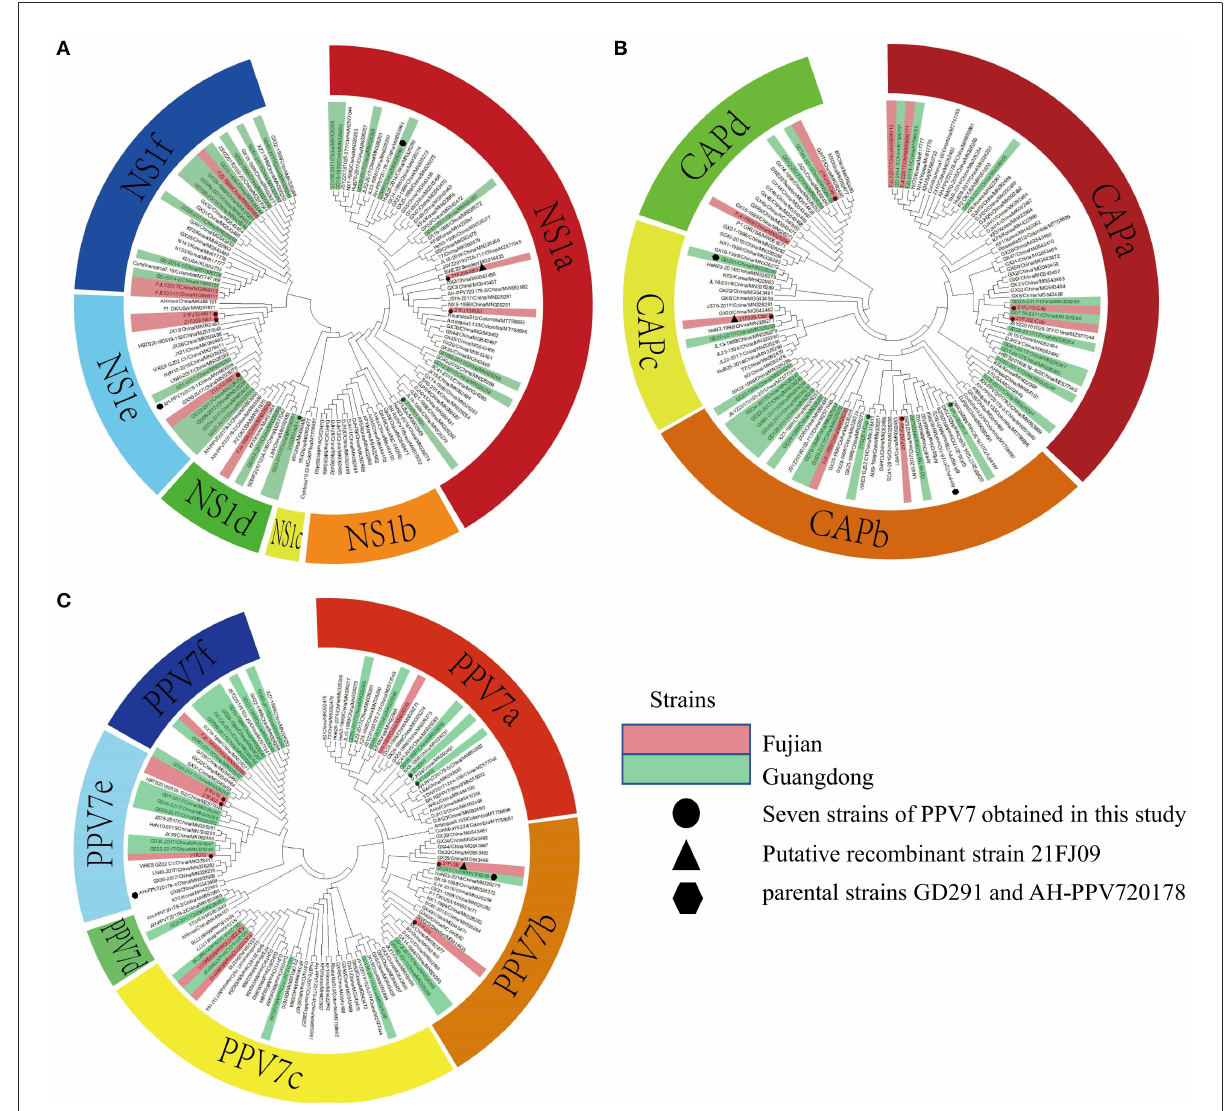
FIGURE2 Phylogenetic analysis of the nucleotide sequences of PPV7. The trees were constructed based on the NS1 (A) , cap (B) , and complete genome sequences (C) by the maximum-likelihood (ML) phylogenetic method, using the General Time Reversible model. The analysis involved 128 nucleotide sequences, including seven sequences obtained from this study and 121 reference strains obtained from the NCBI database. The circles represent the seven strains from this study, the triangles represent the putative recombinant 21FJ09 strain and the hexagons represent the parental strains, GD291 and AH-PPV720178-1. The strains from Fujian and Guangdong are marked as red and green,